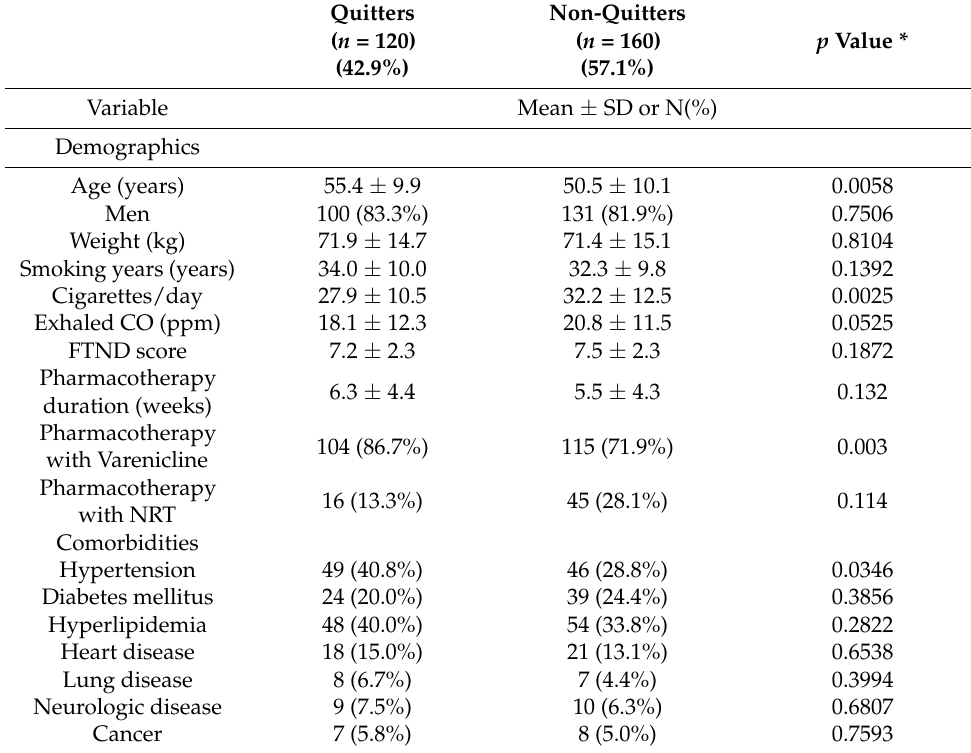
Table 2. Comparison of baseline characteristics related to smoking cessation among quitters and non-quitters.